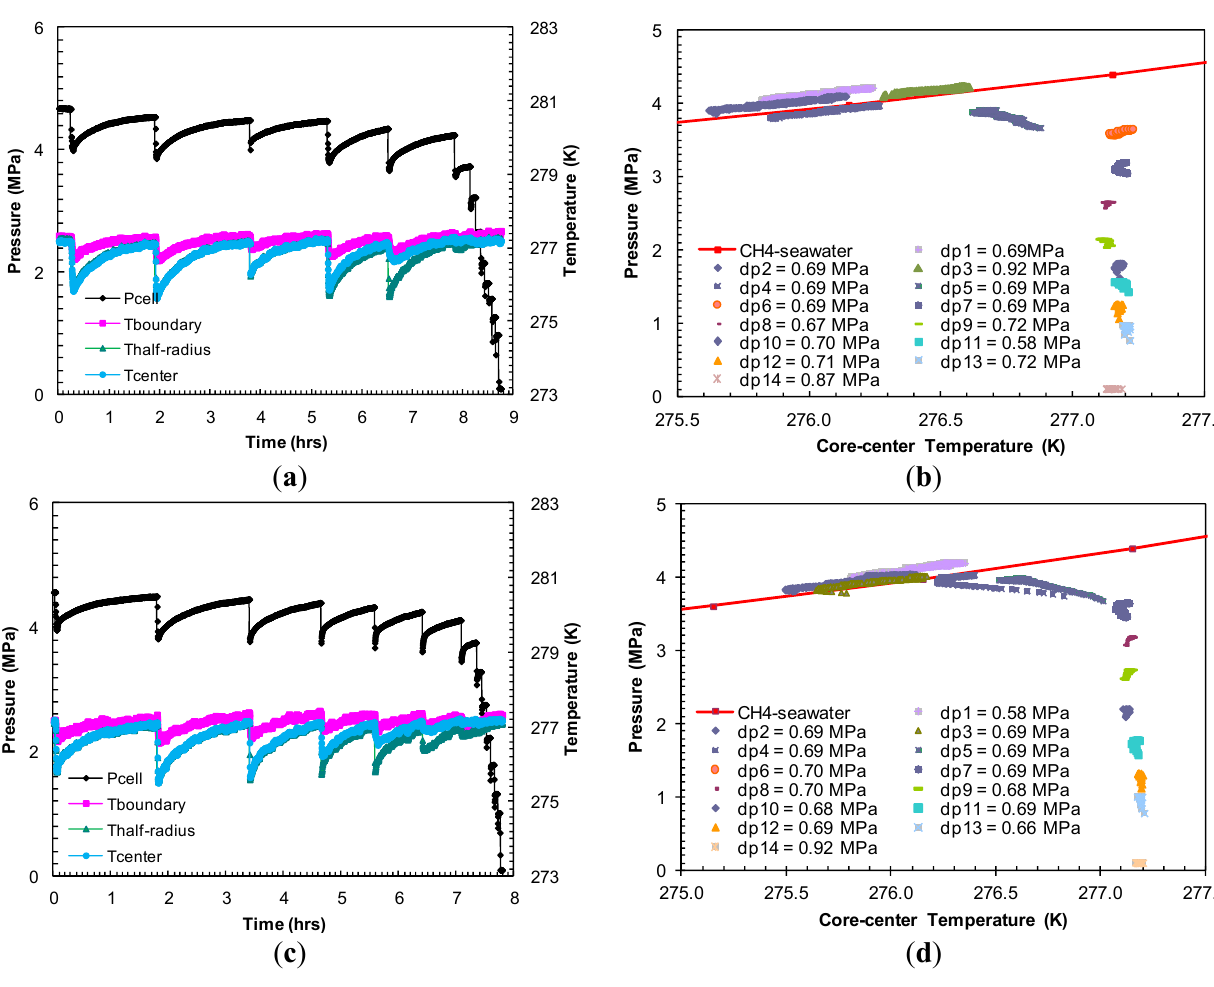
Figure 4. ( a , c ) Cell pressure/temperatures against time during dissociation with sequences of pressure drop and thermally induced dissociation in Experiments 2 and 3; ( b , d ) Post-depressurization equilibrium pressure against temperature measured at the center of the sand-pack in Experiments 2 and 3. Each dataset corresponds to P - T conditions during thermally induced dissociations. Equilibrium conditions of methane hydrates-seawater were obtained from Duan and Sun